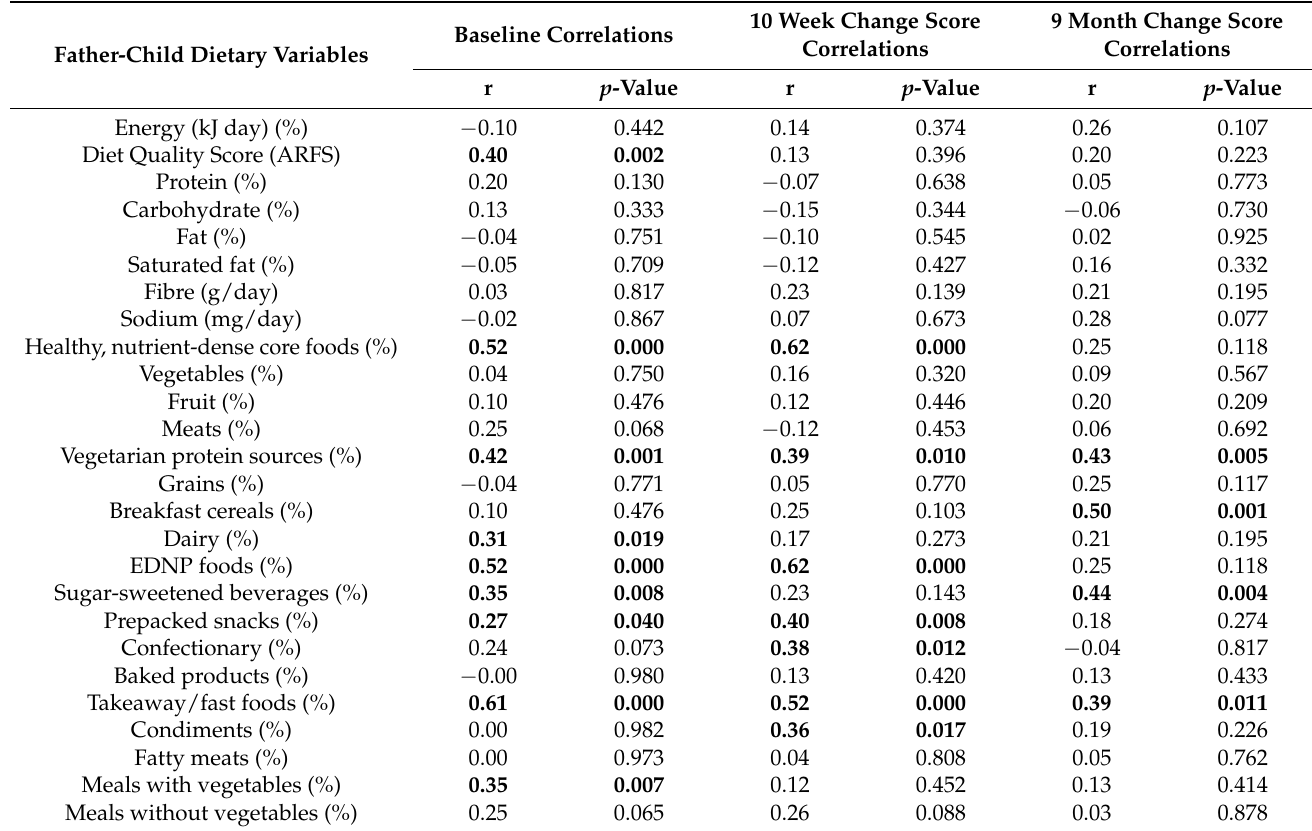
Table 4. Baseline and change score correlations for dietary variables of fathers and their children participating in the ‘Healthy Youngsters, Healthy Dads’